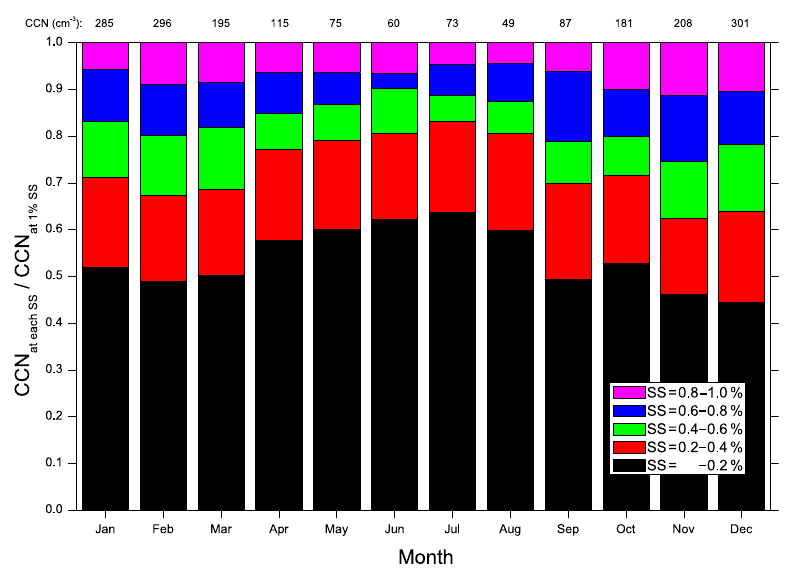
Figure 9. Monthly mean cumulative CCN concentrations shown as fractions of the CCN concentration at the SS of 1.0%. Colours indicate the SS bins. The number at the top of figure represents monthly mean CCN concentrations at the SS values of 1.0%.